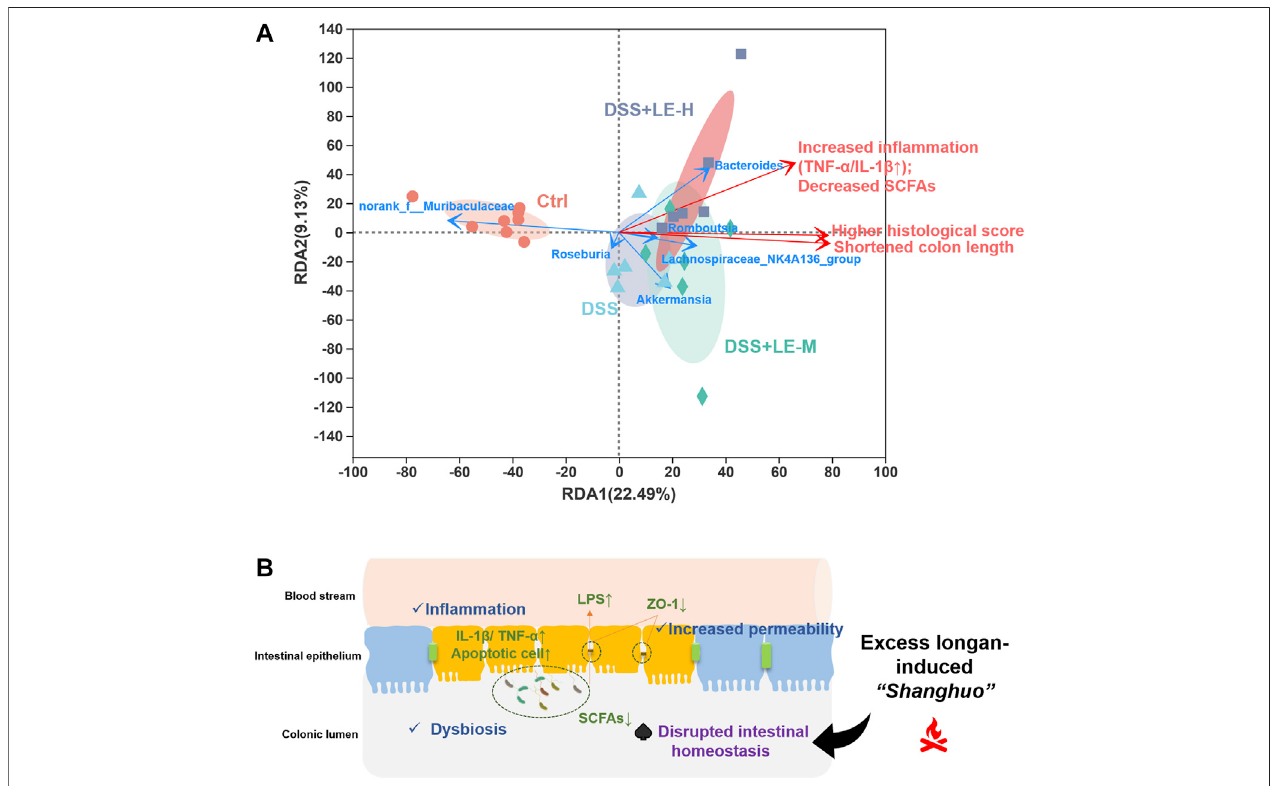
FIGURE9|(A) Redundancyanalysis(RDA)analysisonassociationofkeygenericchangesandpathologicalabnormitiescrossgroups (B) Schematicillustrationof the aggravation of colitis by excessive longan intake and its association with disrupted intestinal homeostasis.